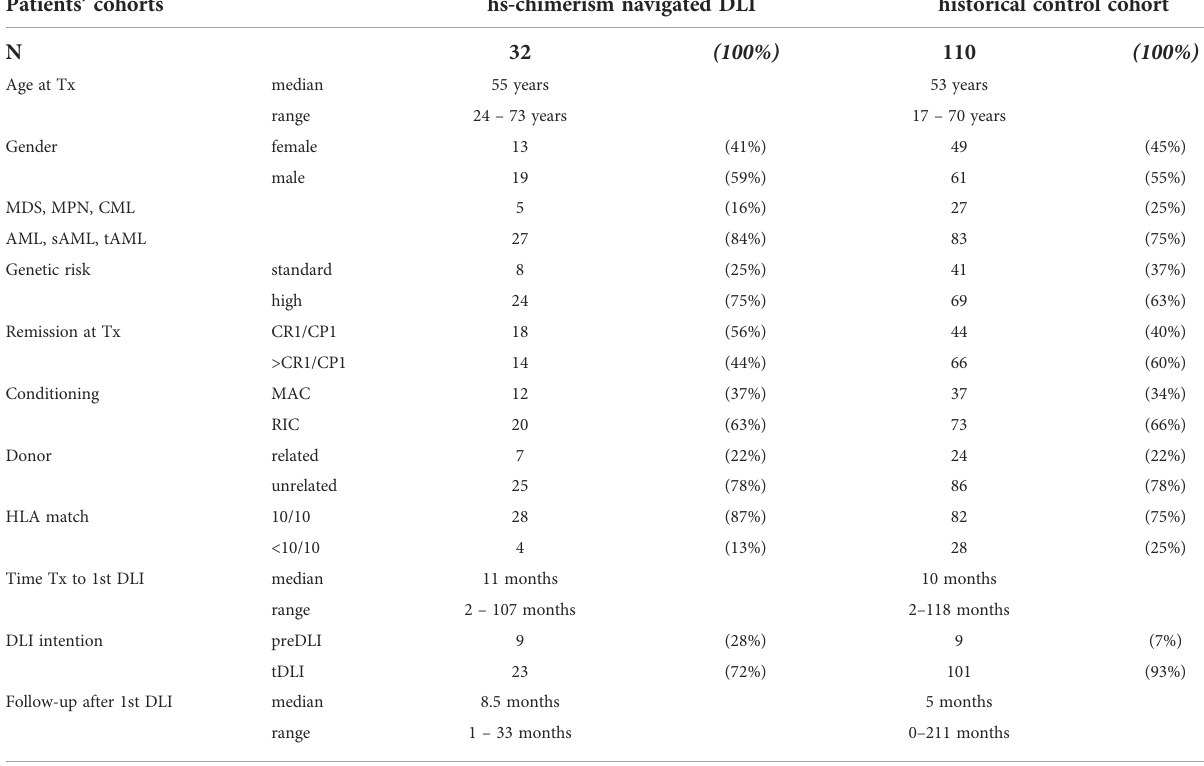
TABLE 1 Patients ’ cohorts hs-chimerism navigated DLI historical control cohort. Patients ’